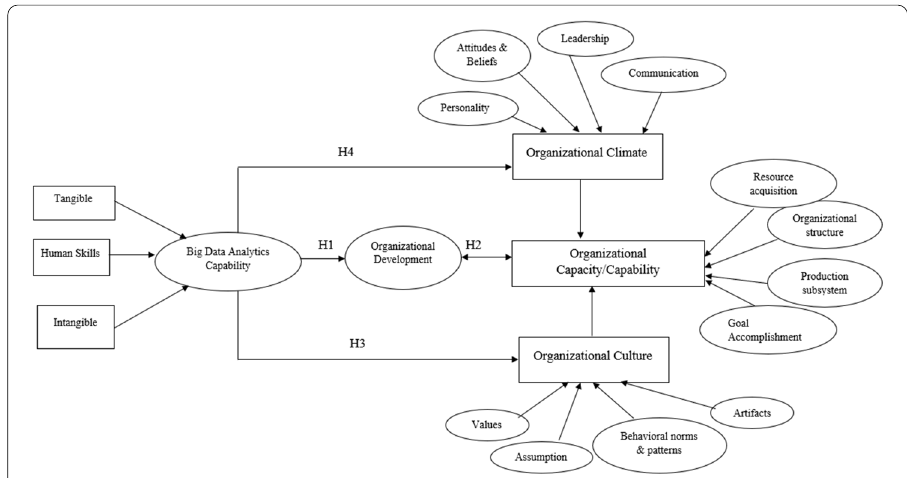
Fig. 7 Proposed interpretation in the research